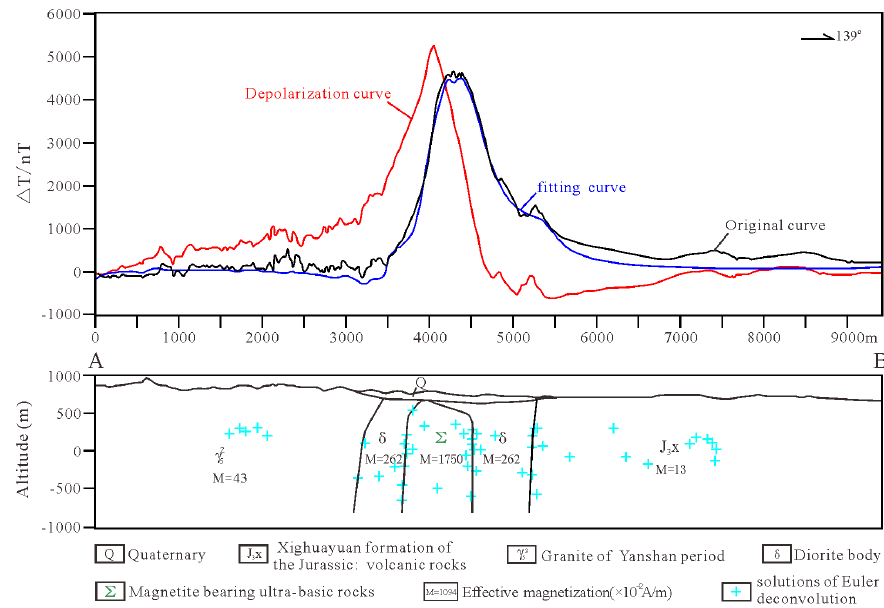
Figure 8. Magnetic data ∆ T profile of the ground survey (line NO. 223). The location of the line is shown in Figure 7a.